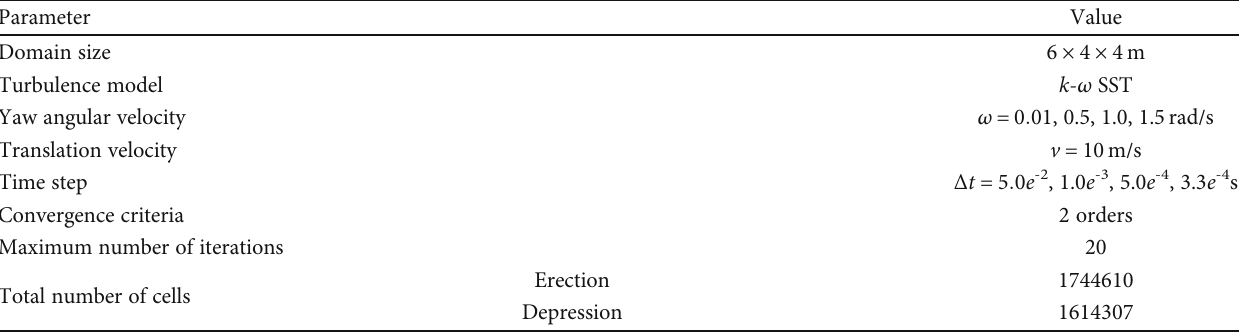
Figure 3: The unstructured hexahedral meshes of the fl ow fi eld and tuna model: (a) the volume mesh of the fl ow fi eld and (b) the surface grid of the tuna model. Table 2: The simulation parameter con fi